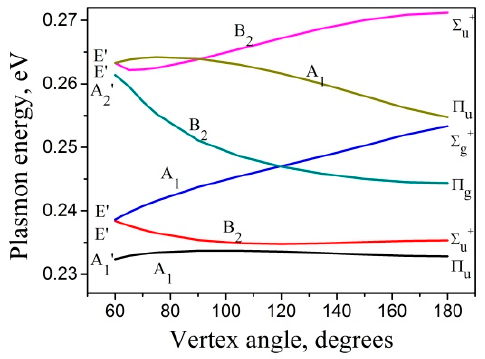
Figure 4. Plasmon energy diagram of trimeric graphene molecules with various vertex